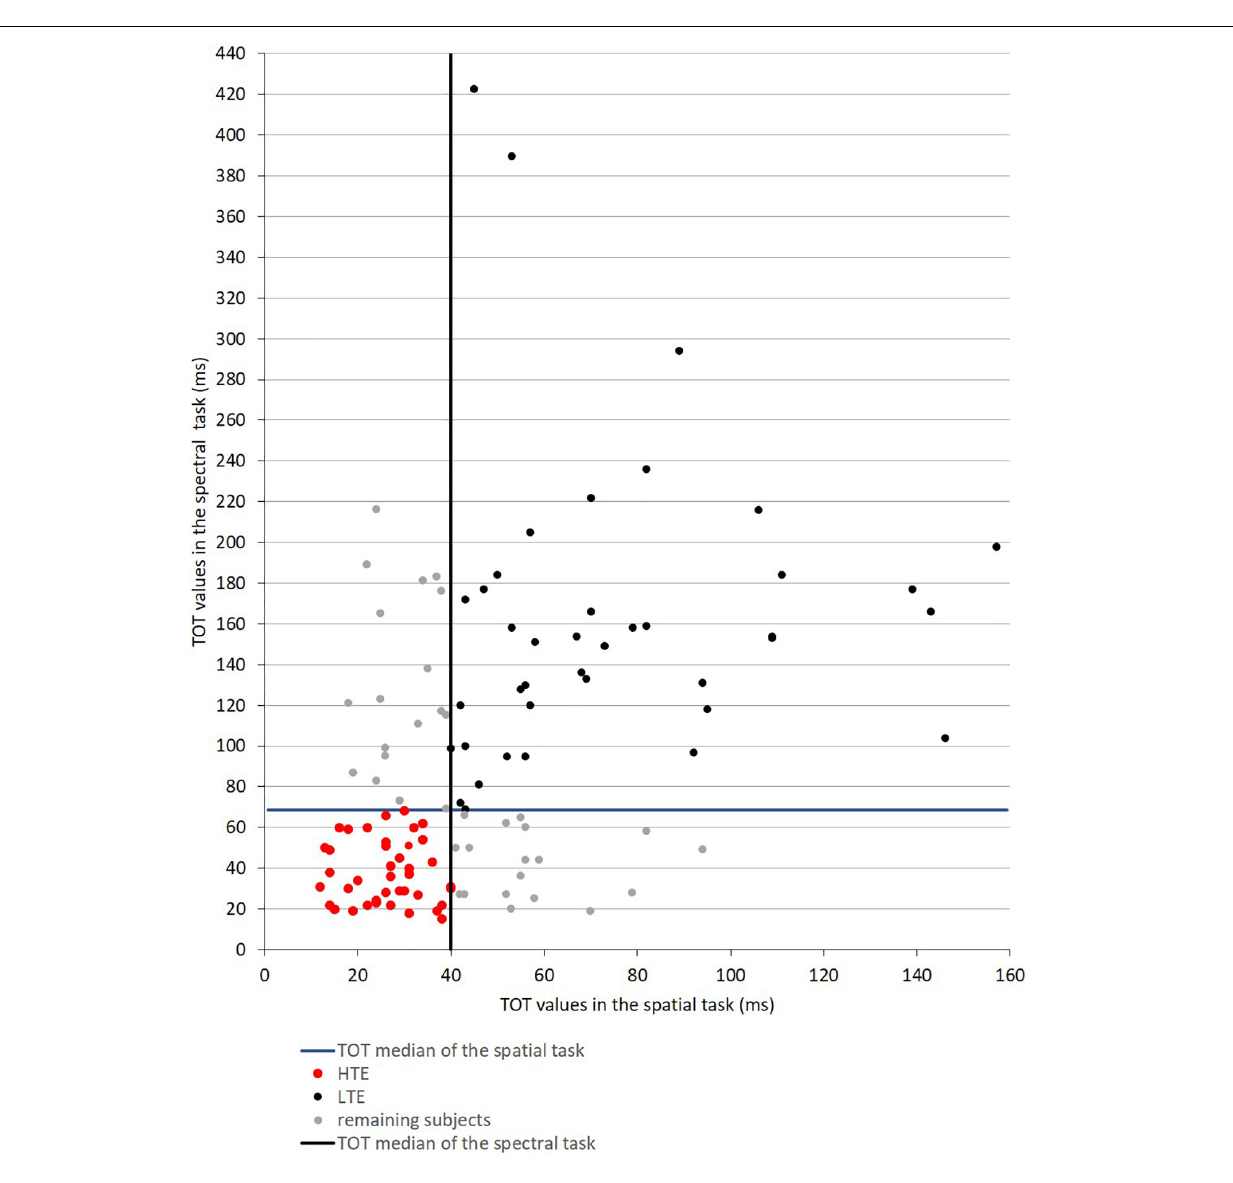
Frontiers in Neuroscience |